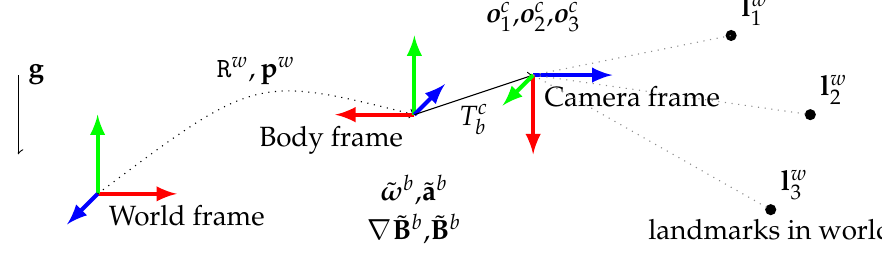
Figure 1. Reference coordinate frames at play in the problem, with associated typical